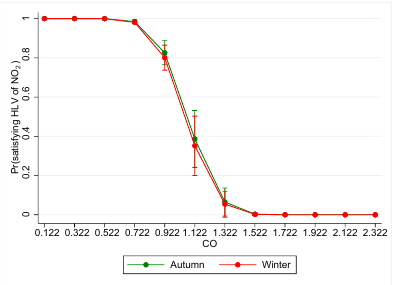
Figure 11. Impact of CO with segmentation by peak traffic hour.